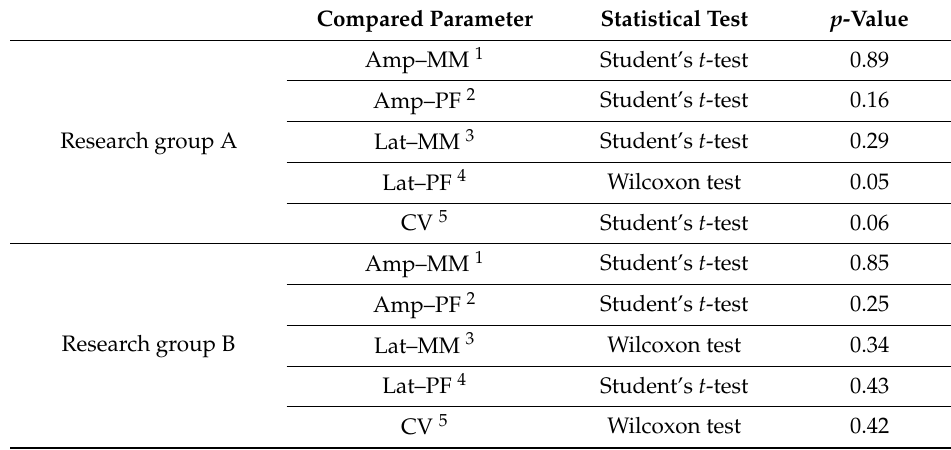
Table 2. Results of comparison of the ENG parameters before and after therapy in research group A and B. A p -value below 0.05 was judged to be statistically